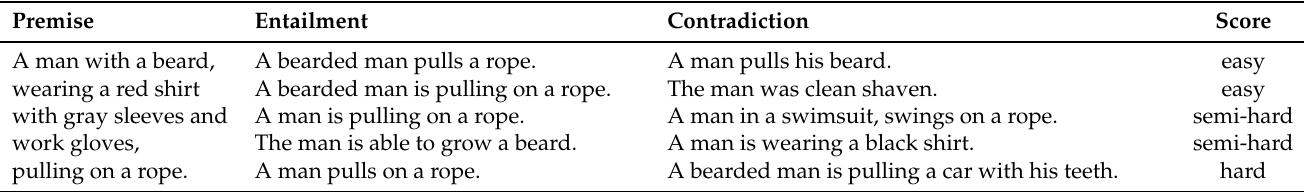
Table 2. Triplet mining for triplet samples from SNLI